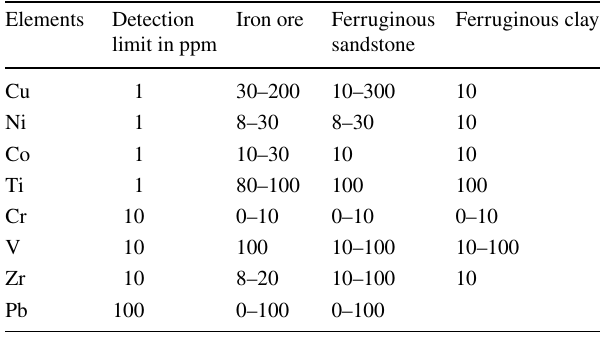
Table 2 Semiquantitative spectrographic analysis (after Nakhla